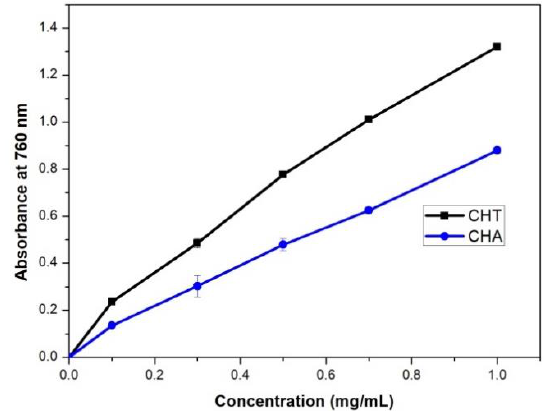
Figure 10. Phenols total concentration of CHT and CHA.